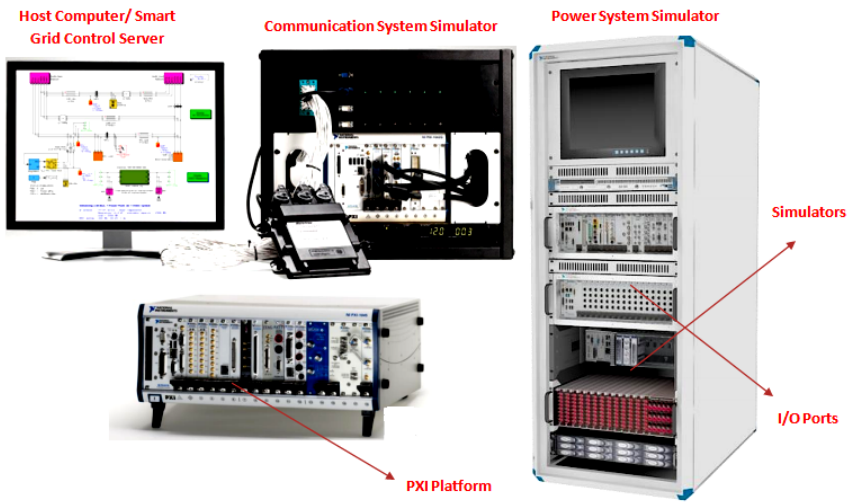
Figure 6. Power Hardware-In-the-Loop (PHIL) setup for DG placement and energy management in the utility network under normal and contingency